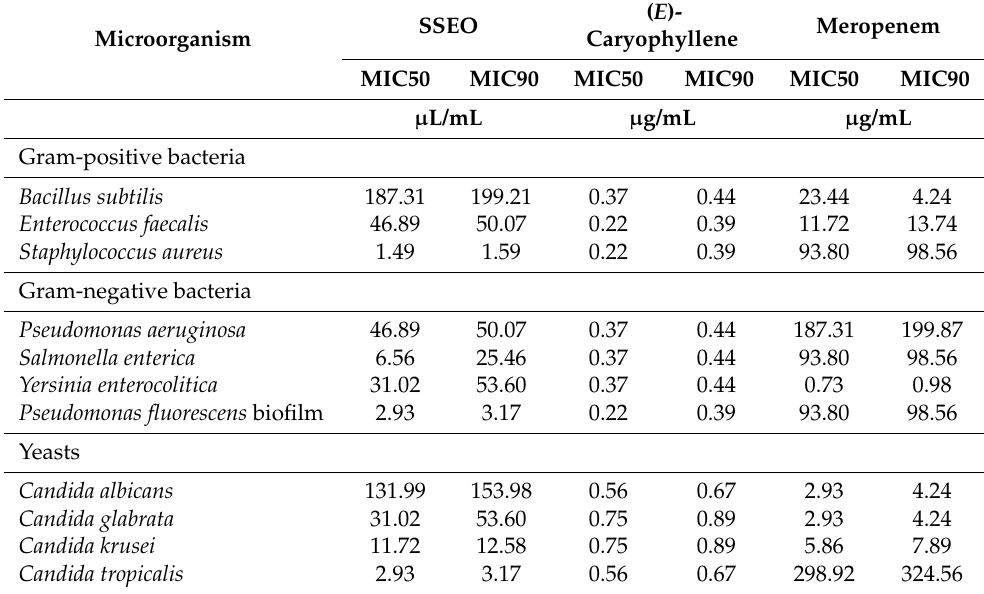
Table 5. Minimal inhibition concentration of SSEO, ( E )-caryophyllene, and